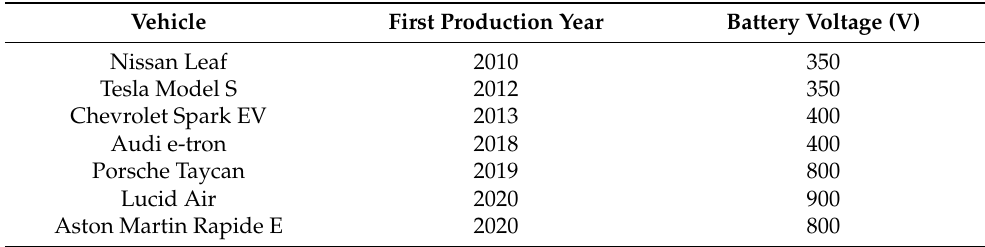
Table 2. Battery Voltage of Some EVs on the Market